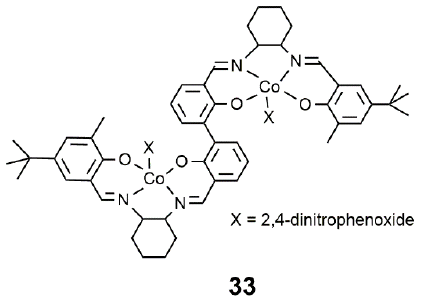
Figure 13. Enantiopure chiral dinuclear (S,S,S,S)- 33 complex [59]. More in detail, when an equimolar amount of CHO and BBL is present in the feed, the terpolymerization proceeds smoothly with the good conversion of both monomers ( p CO 2 = 2 MPa, T = 40 °C, t = 2–4 h). The resulting copolymers display, in the 1 H NMR spectra, the signals relative to the carbonate-ester linkages, indicating a multiblock struc- ture. Molecular weights are rather low, M n = 3.3–14.6 kg mol − 1 , with narrow dispersity ( Ð = 1.19–1.44), and display thermal behavior with a T m = 204–220 °C, evidencing the presence of stereoregular crystalline blocks along the polymer chain. In Table 2, the main data relating to the terpolymerizations of CO 2 with epoxides and cyclic esters discussed in this second part are summarized. Table 2. Summary of terpolymerization of CO 2 with epoxides and cyclic esters. Catalyst